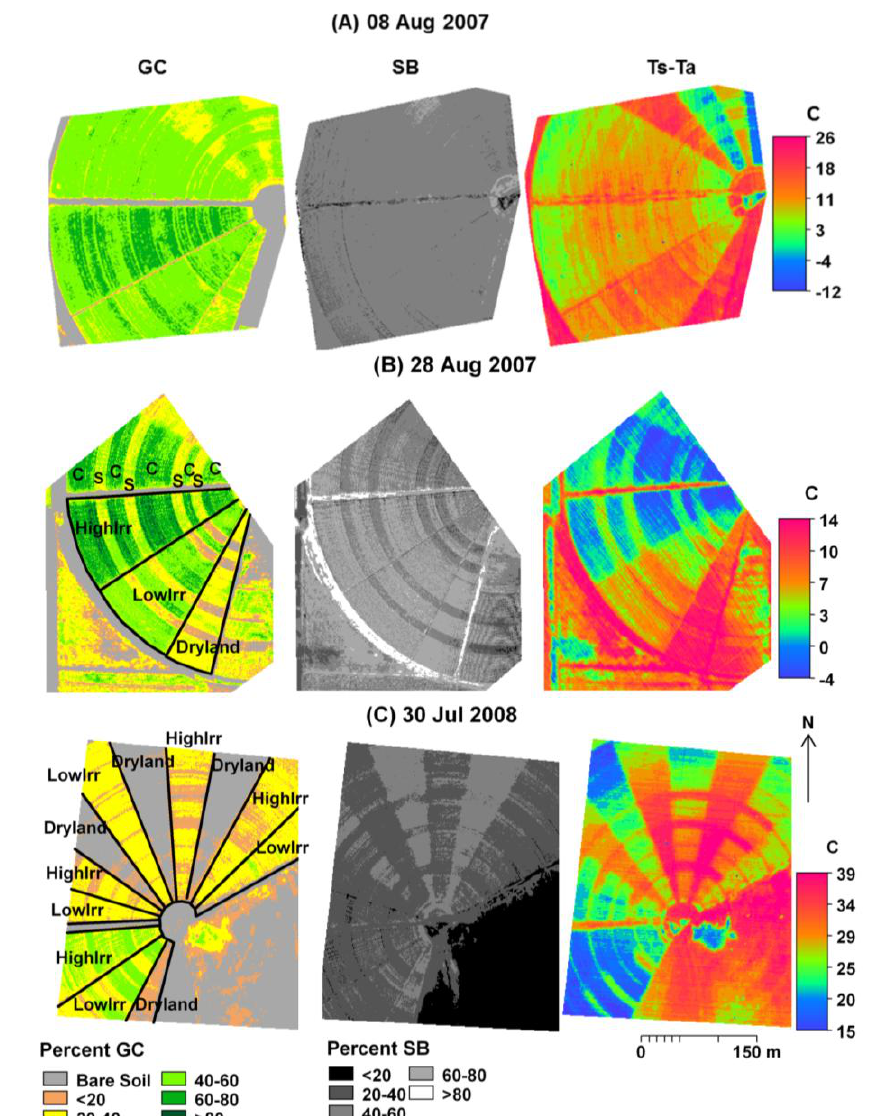
Figure 5. Percent of ground cover (GC) of cotton (C) and sorghum, Sorghum bicolor (S), percent soil brightness (SB) and canopy minus air temperature ( Tc-Ta ) (°C), for two dates in 2007 ( A , B ) and 2008 ( C ) along with the respective irrigation plots for the highly irrigated (HighIrr), low irrigated (LowIrr) and dryland